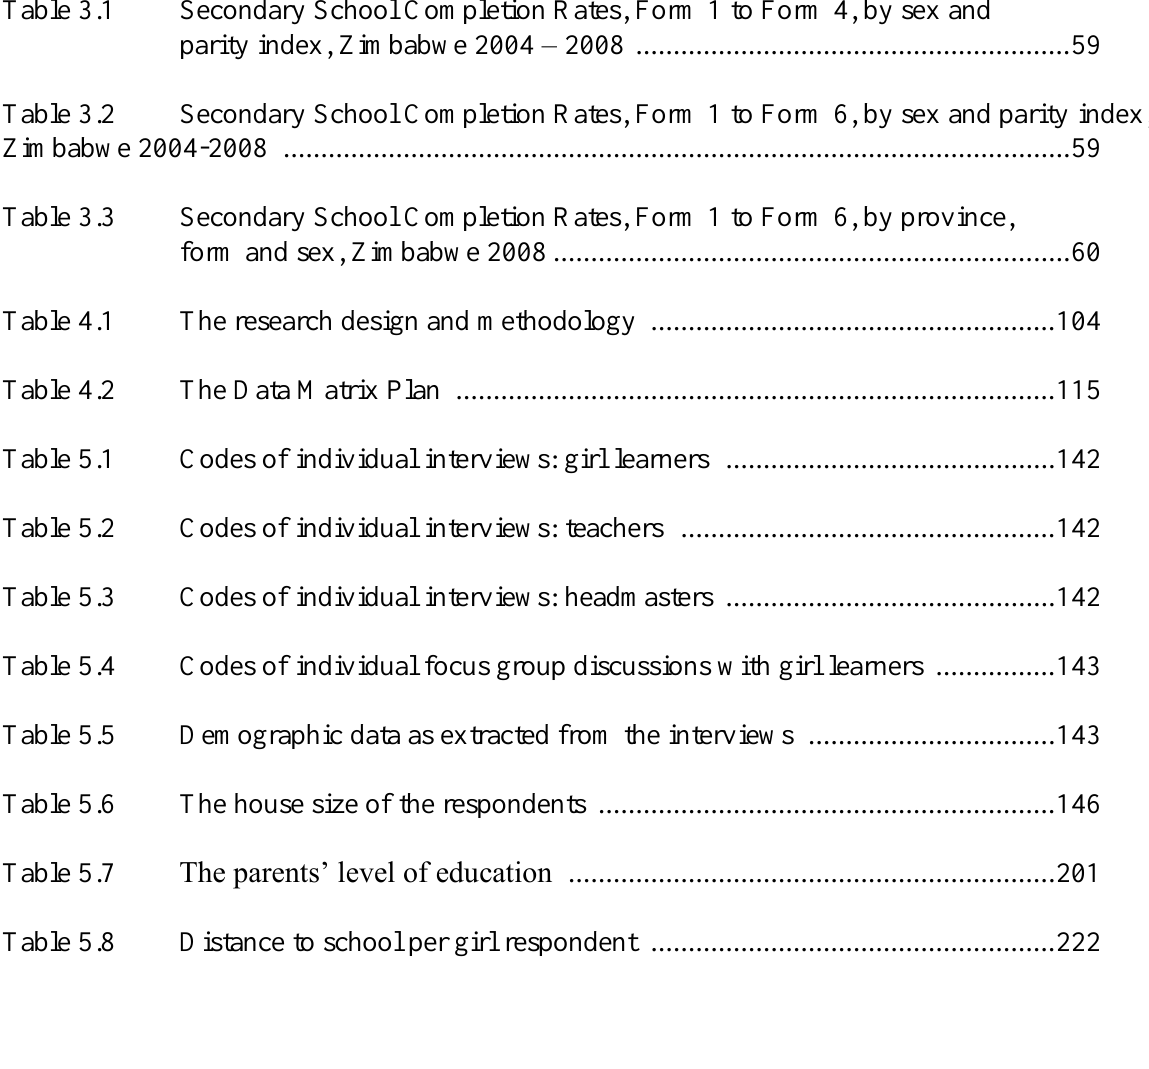
Table 5.6 Table 5.7 Table